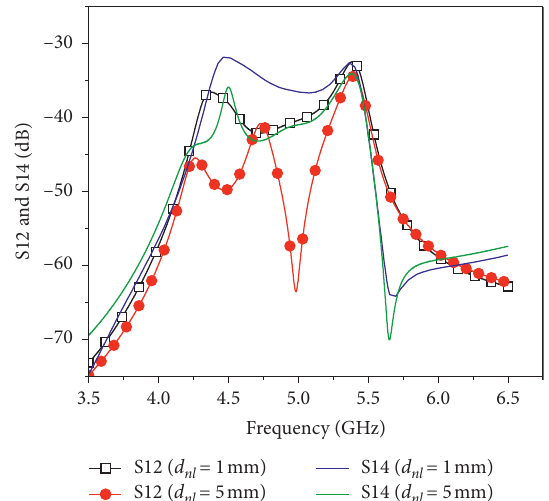
Figure 8: Simulated S12 and S14 of the MIMO antenna with variations in d